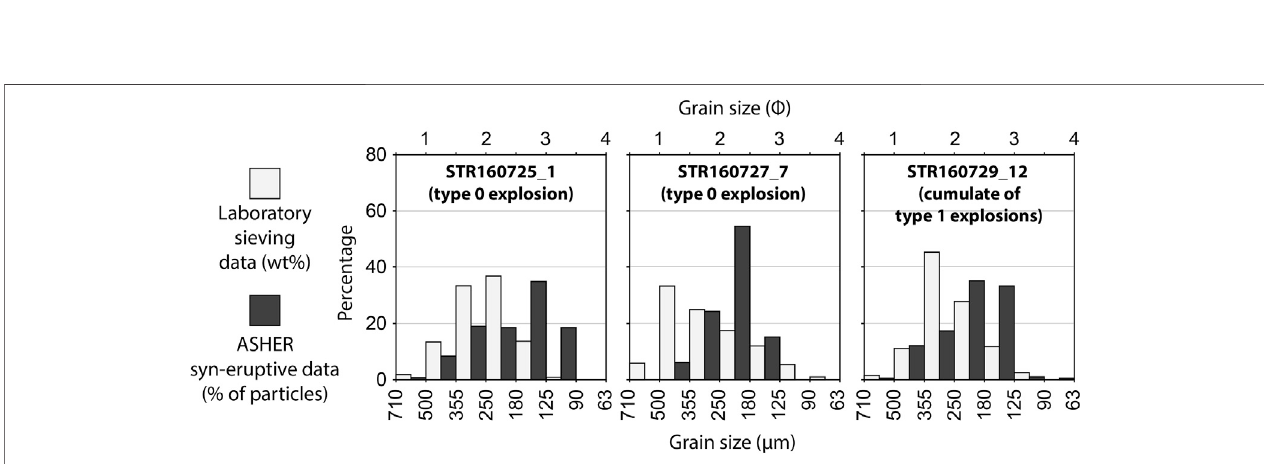
FIGURE 7 | Grain size of the three collected ash samples measured both by the ASH collector and sizER (ASHER) instrument and by laboratory sieving.